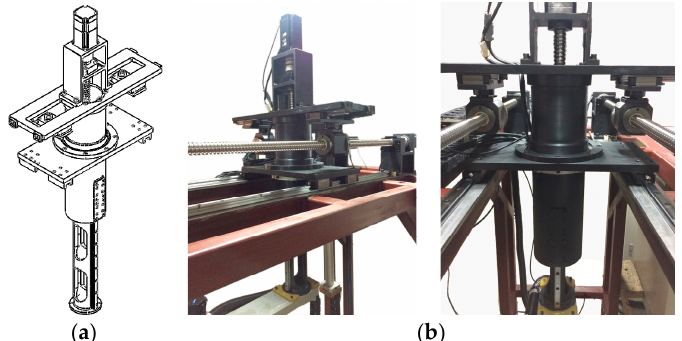
Figure 4. Vertical axis assembly of the improved platform: ( a ) design structure; ( b ) physical structure.